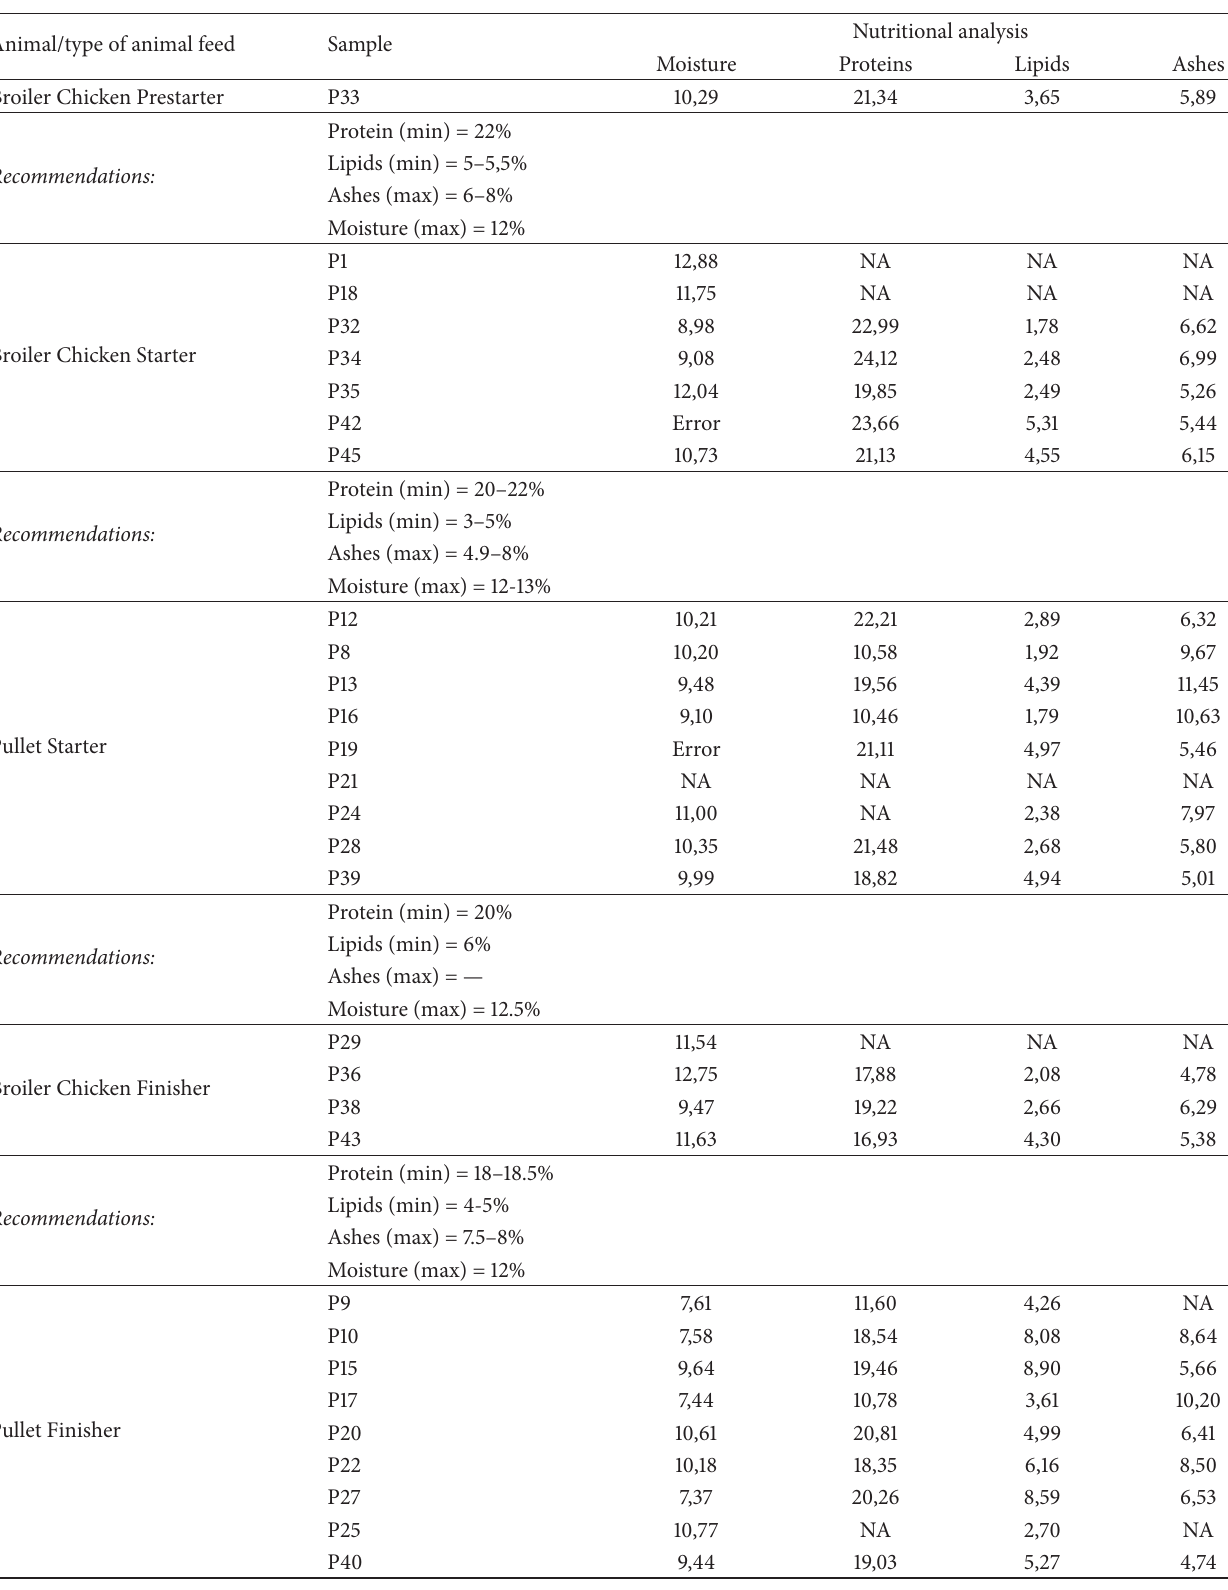
Table 5: Nutritional composition of poultry feed samples analyzed and recommendations (NA: not analyzed). Animal/type of animal